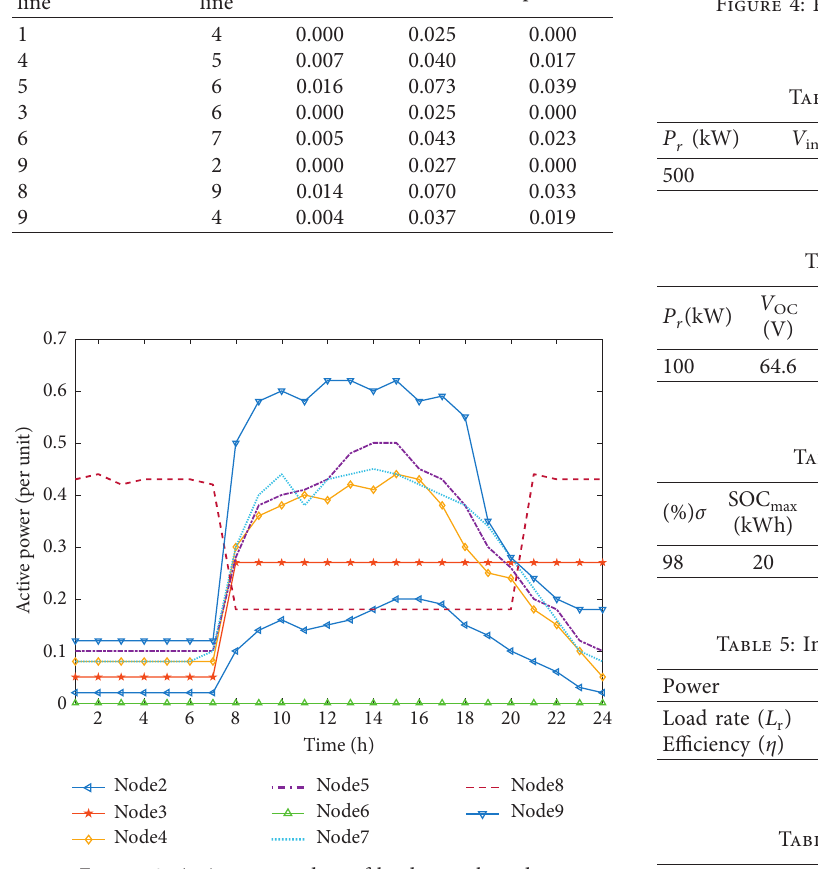
Figure 3: Active power data of load at each node.